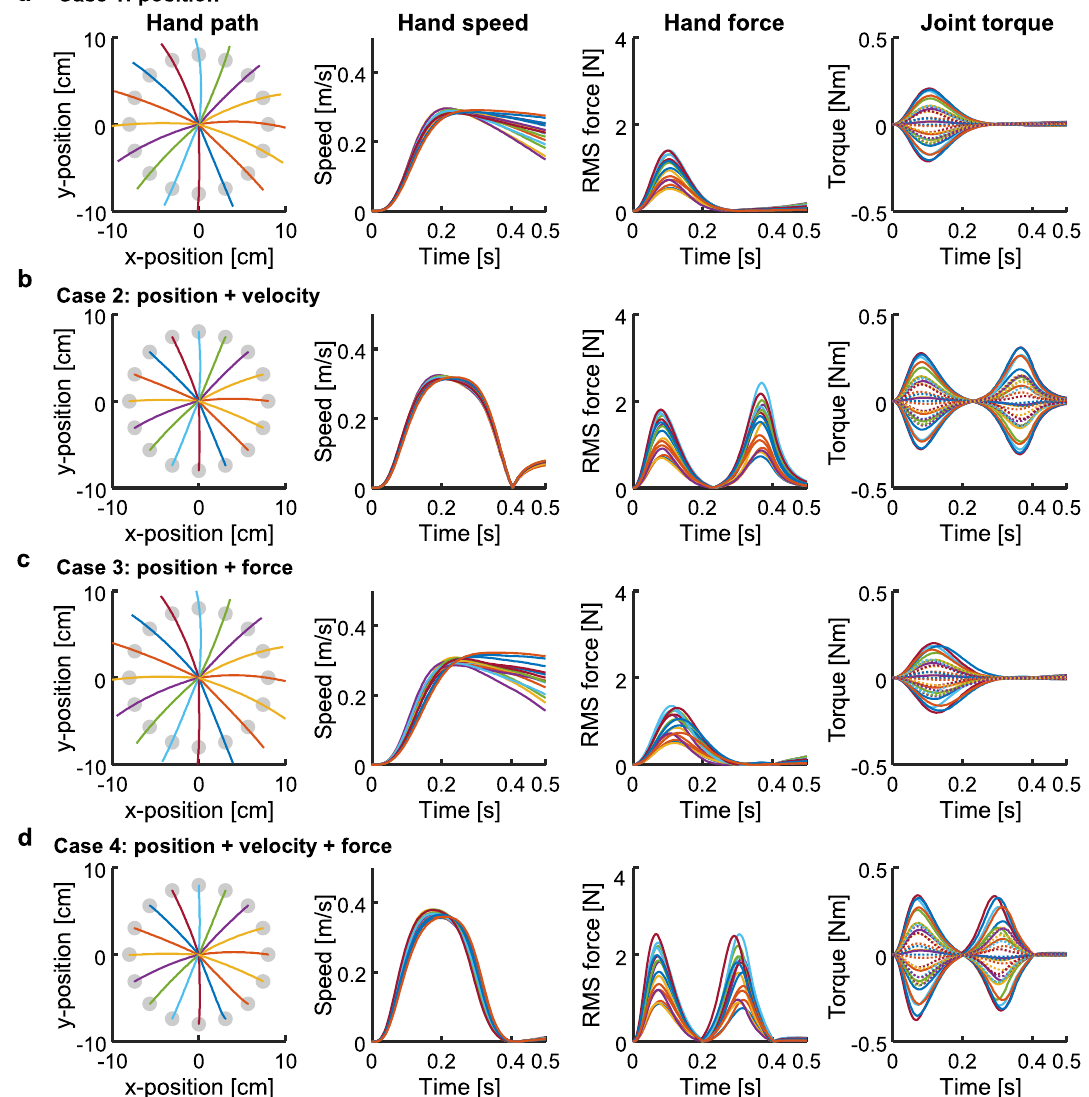
Figure 2. Centre-out movement for 16 targets. Columns from left to right are the hand paths, hand speed profiles, root mean squared (RMS) hand force profiles, and joint torque profiles. In the hand paths, target positions are shown as filled circles. In the joint torque profiles, solid and dotted lines indicate torques of the shoulder and elbow joints, respectively. Cases 1–4 are in rows ( a )–( d ), because a passive tensile force was generated by stretching the muscles. In Case 2, the hand stopped on the tar- gets and the speed was almost set to zero at the movement end, although slight motions were observed after the